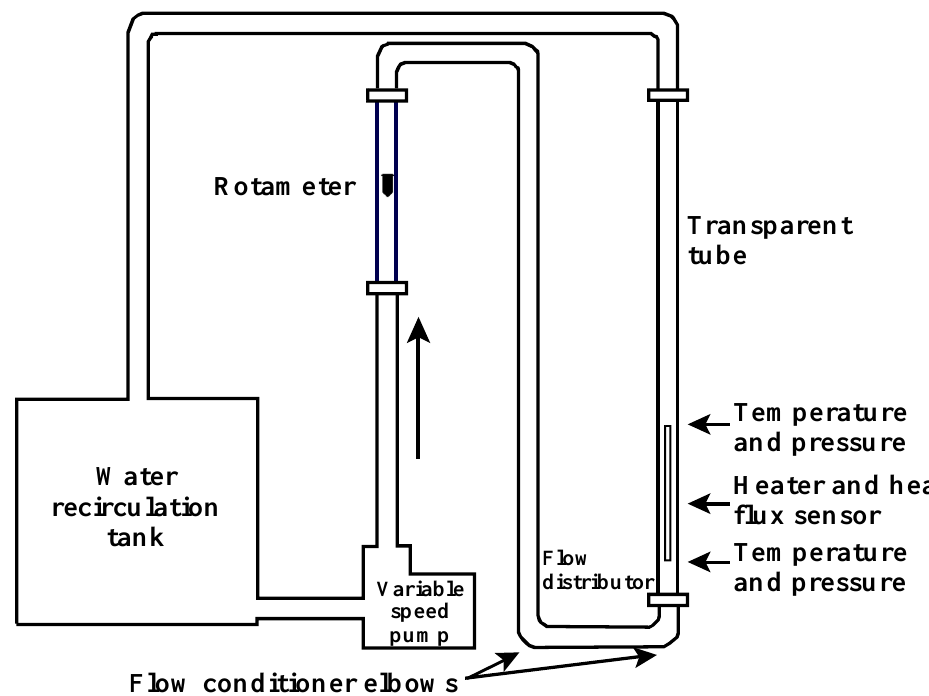
Figure 4. Experimental system layout .